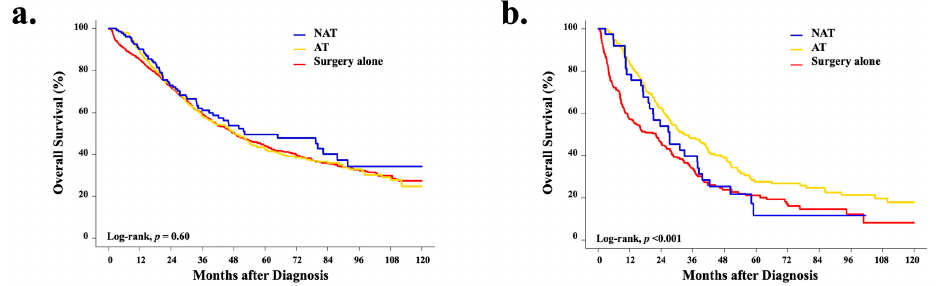
Figure 5. Unadjusted Kaplan–Meier curves for overall survival by treatment strategy for patients who underwent ( a ) R0 resection ( n = 2082) and ( b ) R1 or R2 ( n = 491) resections for intrahepatic cholangiocarcinoma.